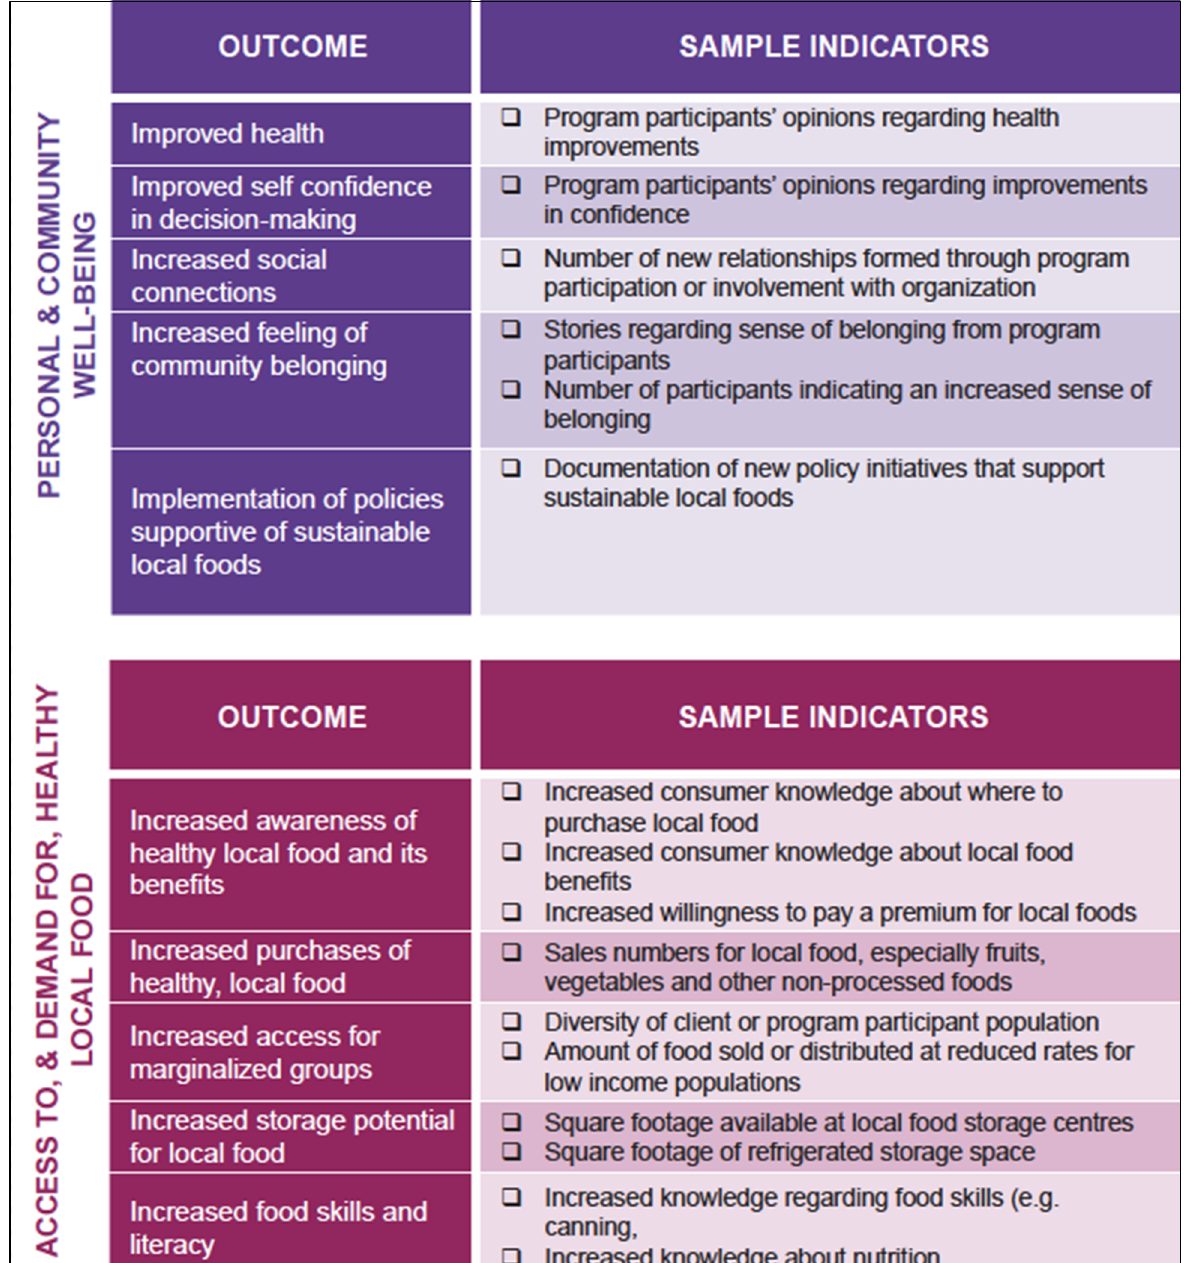
Figure 2. Sample Outcomes and Associated Indicators for Community Food Hubs (from Nelson & Landman,